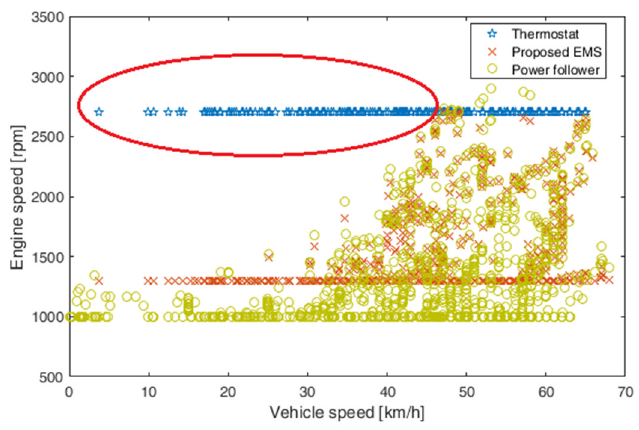
Figure 31. Engine speed vs vehicle speed (fast-urban